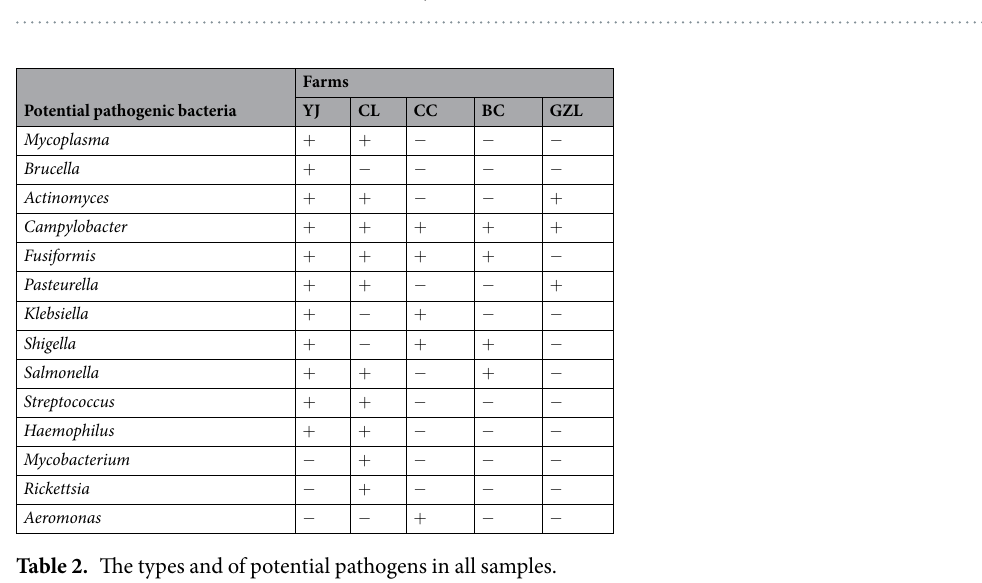
Figure 2. Proportion of taxonomical phyla in different sheep farms. BC: The incidence of bacterial disease was 0.02%; CC: The incidence of bacterial disease was 0.01%; CL: The incidence of bacterial disease was 7%; GZL: The incidence of bacterial disease was 0.5%; YJ: The incidence of bacterial disease was 12.